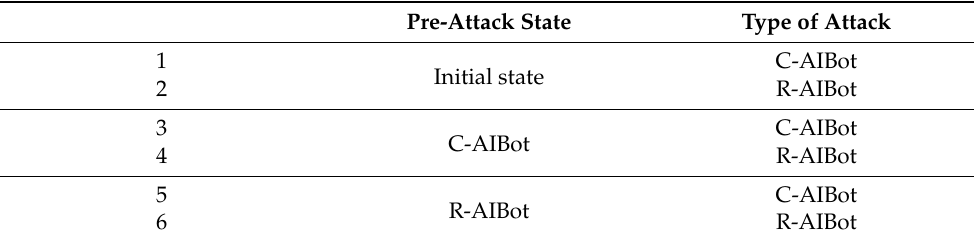
Figure 17. Variation in average traffic with the number of nodes for different text lengths. Table 1. Experimental